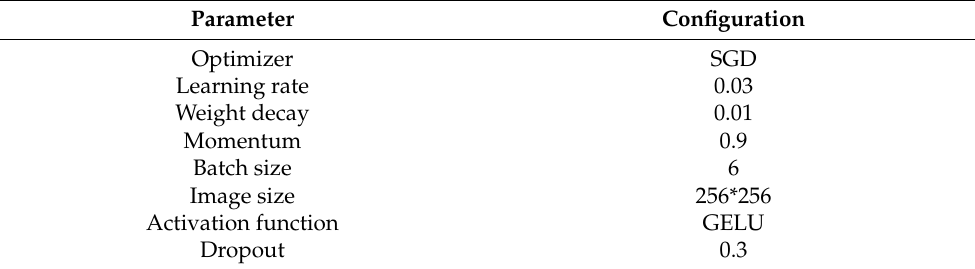
Table 2. Hyper-parameters of all the models used in this study. Parameter Configuration Optimizer SGD Learning rate 0.03 Weight decay 0.01 Momentum 0.9 Batch size 6 Image size 256*256 Activation function GELU Dropout